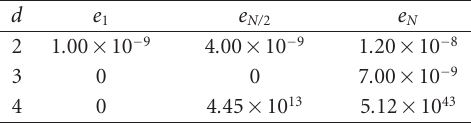
Table 6.10. Approximate error for Example 6.1.